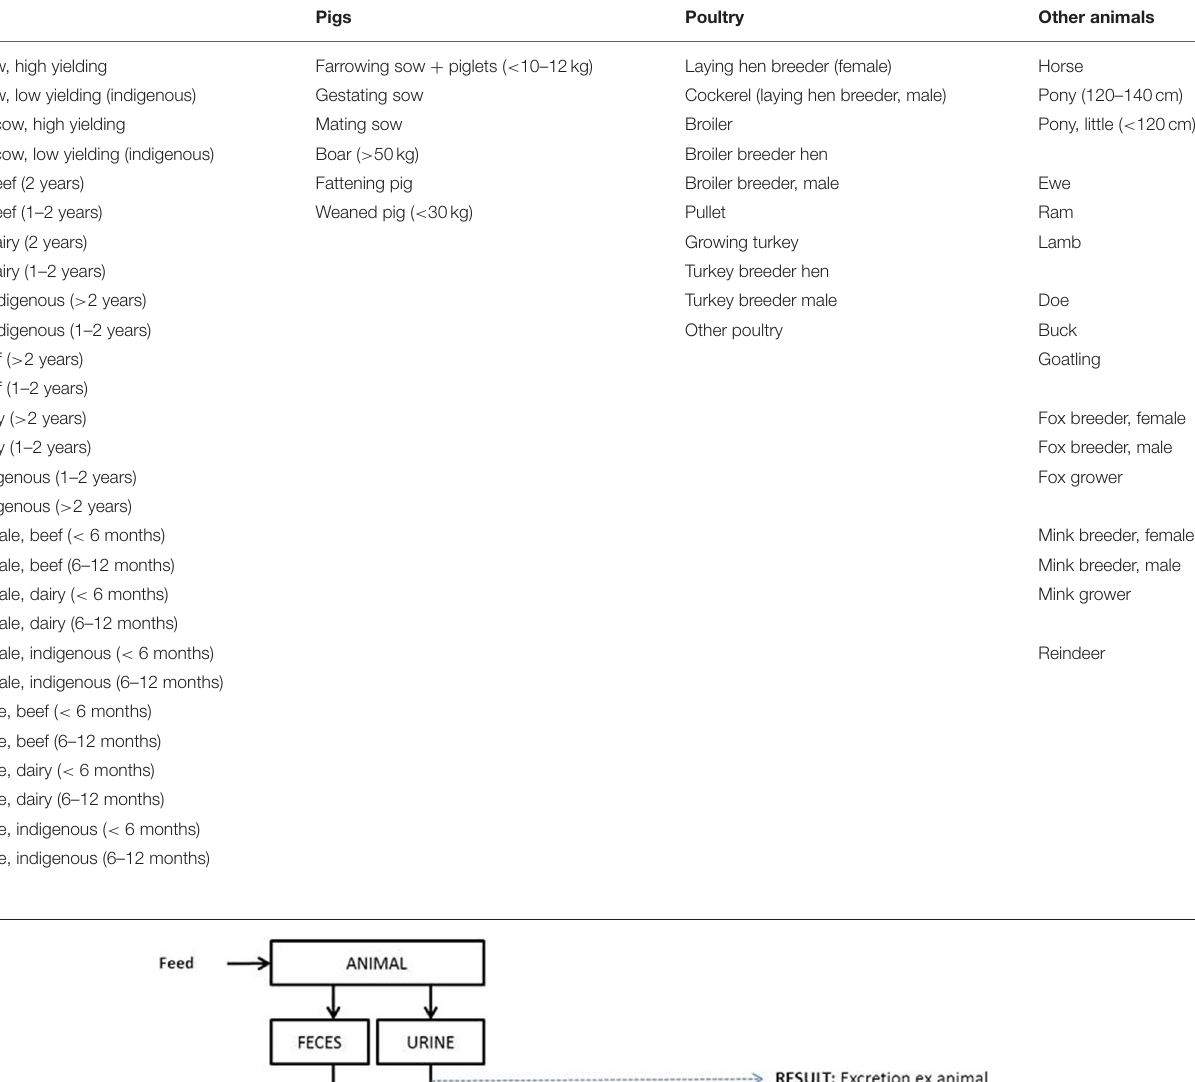
Frontiers in Sustainable Food Systems |